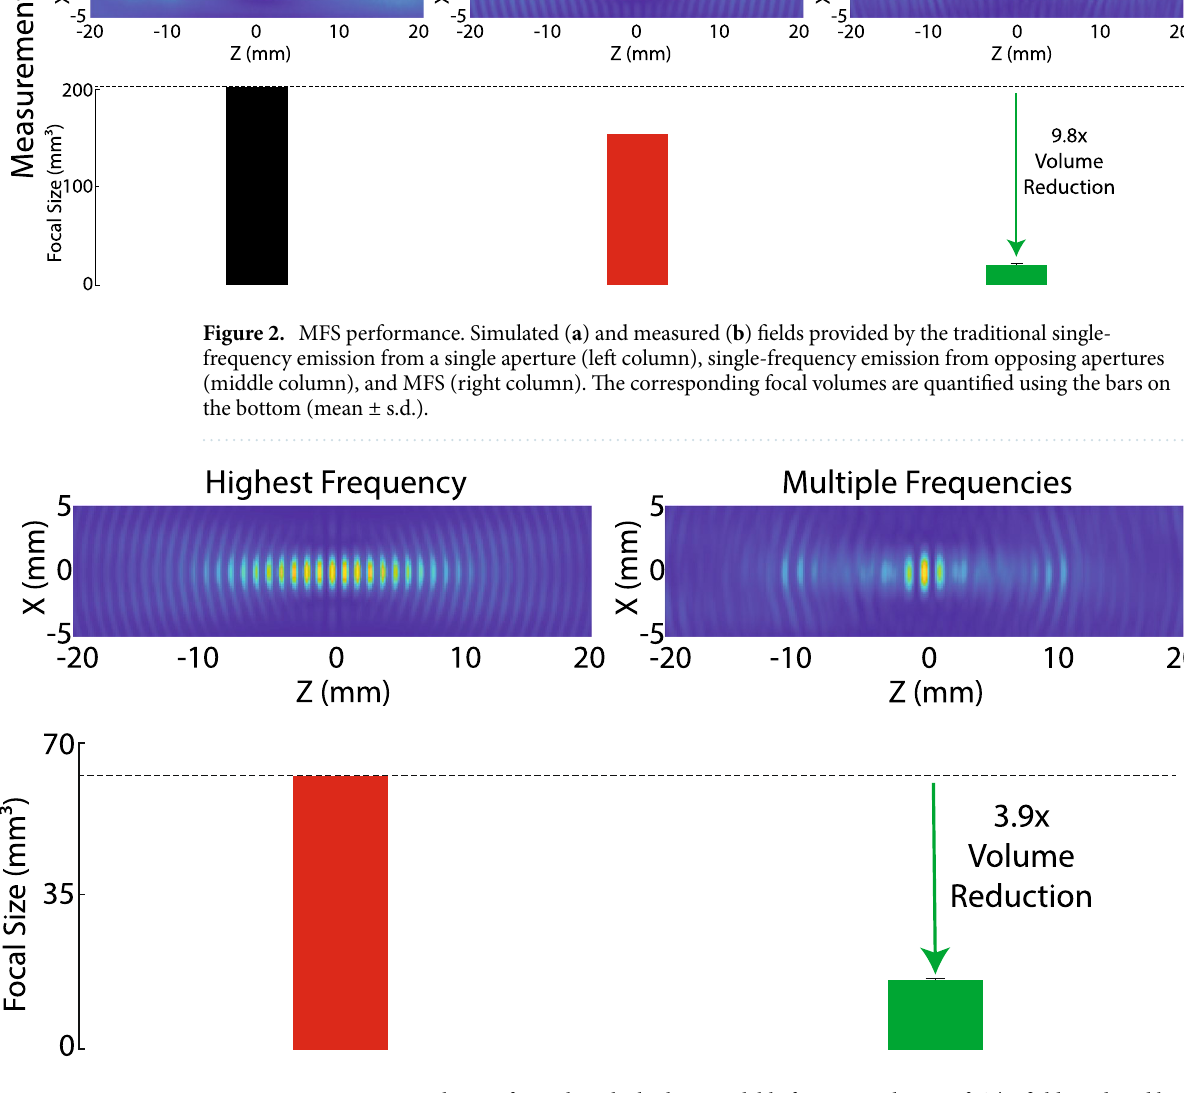
Figure 3. MFS generates sharper focus than the highest available frequency alone. Left: The field produced by the highest frequency available within the MFS bandwidth. Right: MFS. Error bars represent the s.d. Both fields were obtained using simulations analogous to those of Fig.